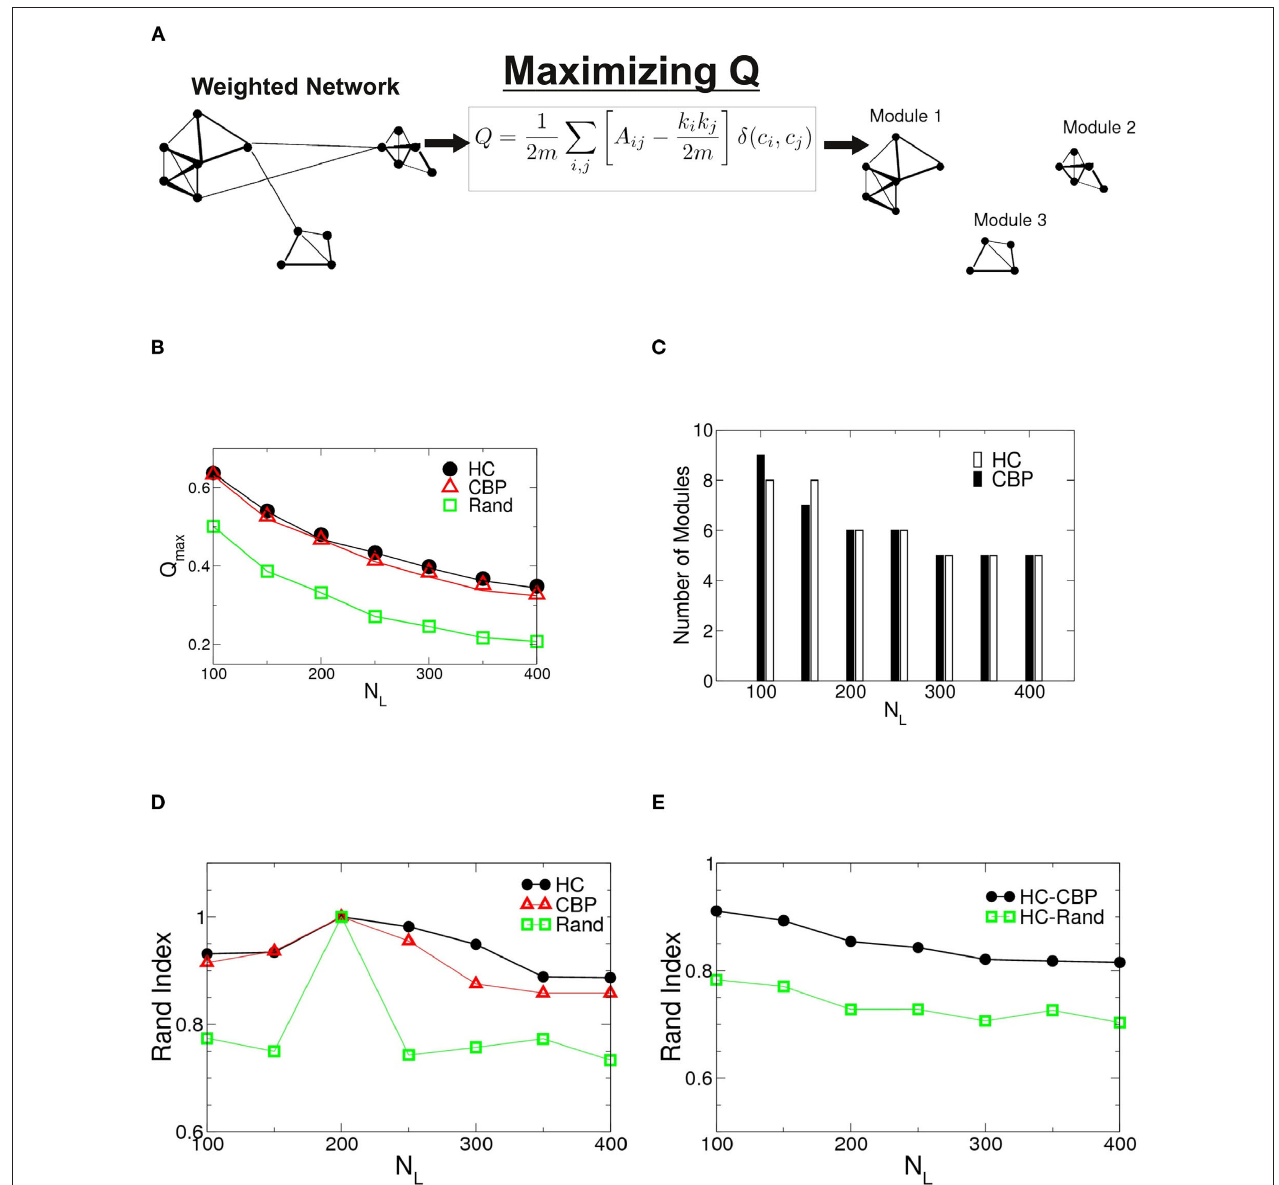
for HC (black circles), CBP (red triangles), and equivalent random weighted Figure 2 | (A) Schematic representation of the algorithm to find modularity networks (green squares). (e) Rand index between partitions of HC and CBP (Eq. 5) identifying nodes mutually connected more strongly than with the rest of (black circles) as a measure of module’s similarity in both groups. The Rand index the network. (B) Changes in the maximum modularity as a function of the is also calculated between HC and equivalent random weighted networks number of links, N for both groups as well as for an equivalent random network. L (green squares). The difference between both groups community’ structures is (C) Number of modules at Q as a function of N for both groups. (D) max L smaller than the difference expected between HC and an equivalent random Robustness of the communities structures. Rand index of partitions obtained for different values of N = {100,150,250,350,400} compared with those of N = 200 L L